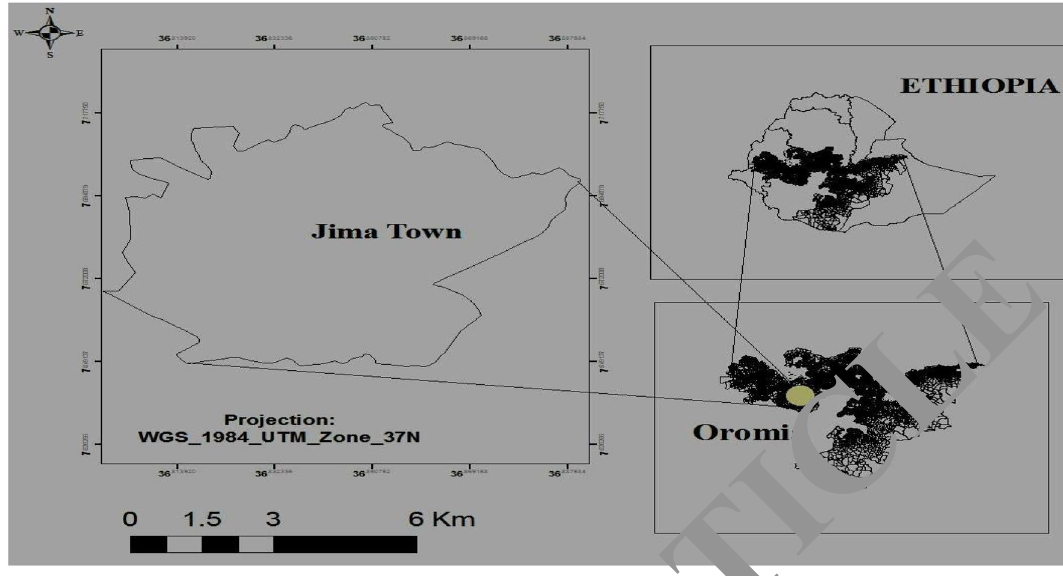
Figure 2. Map of the study area. (Generated by Destaw A. Ali using QGIS 2.18 software. https:// qgis. org/ en/ site/ forus ers/ visua lchan gelog 218/ index.